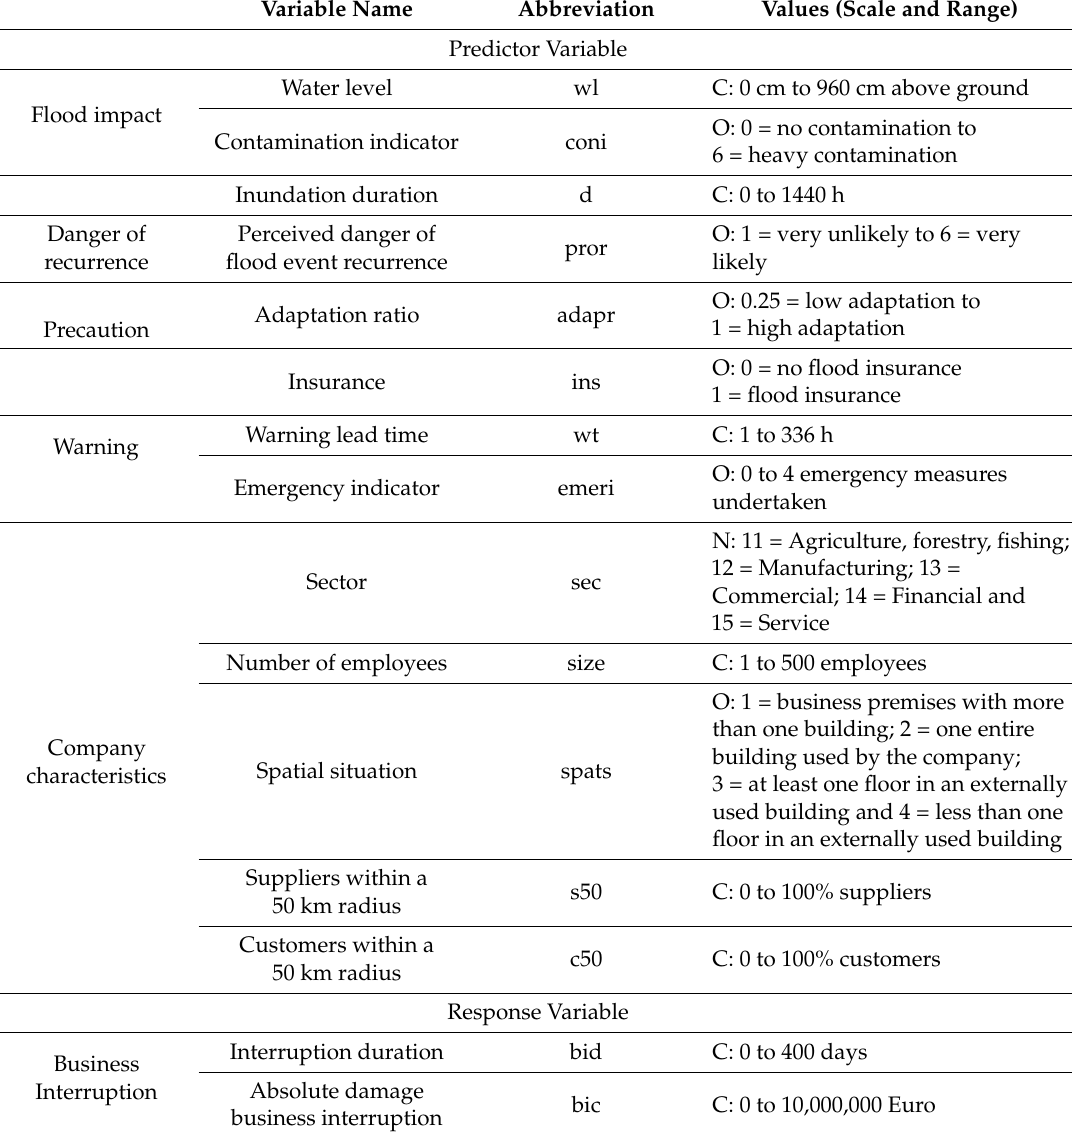
Table 1. Important variables compilation related to business